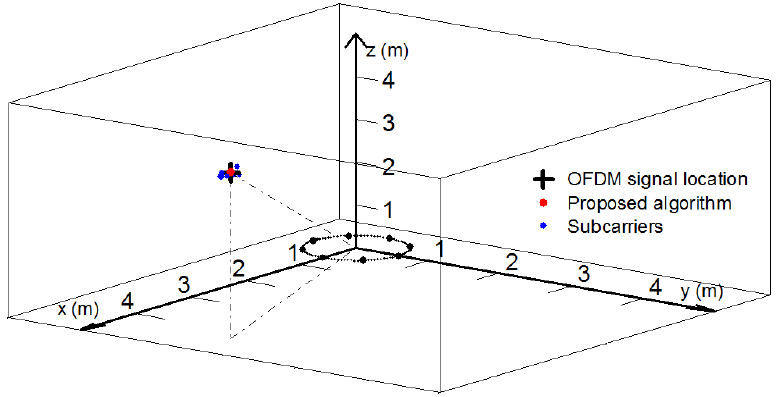
Figure 6. Positioning result (SNR = 20 dB).